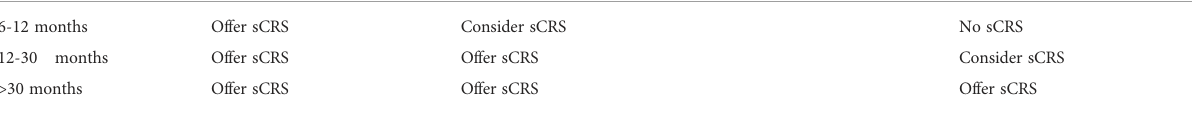
TABLE 4 The MSK criteria